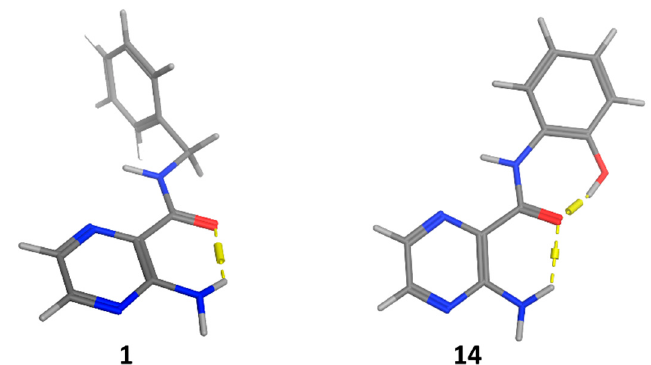
Figure 2. Lowest energy conformers of compounds 1 and 14 with visualization of intramolecular hydrogen bonds.